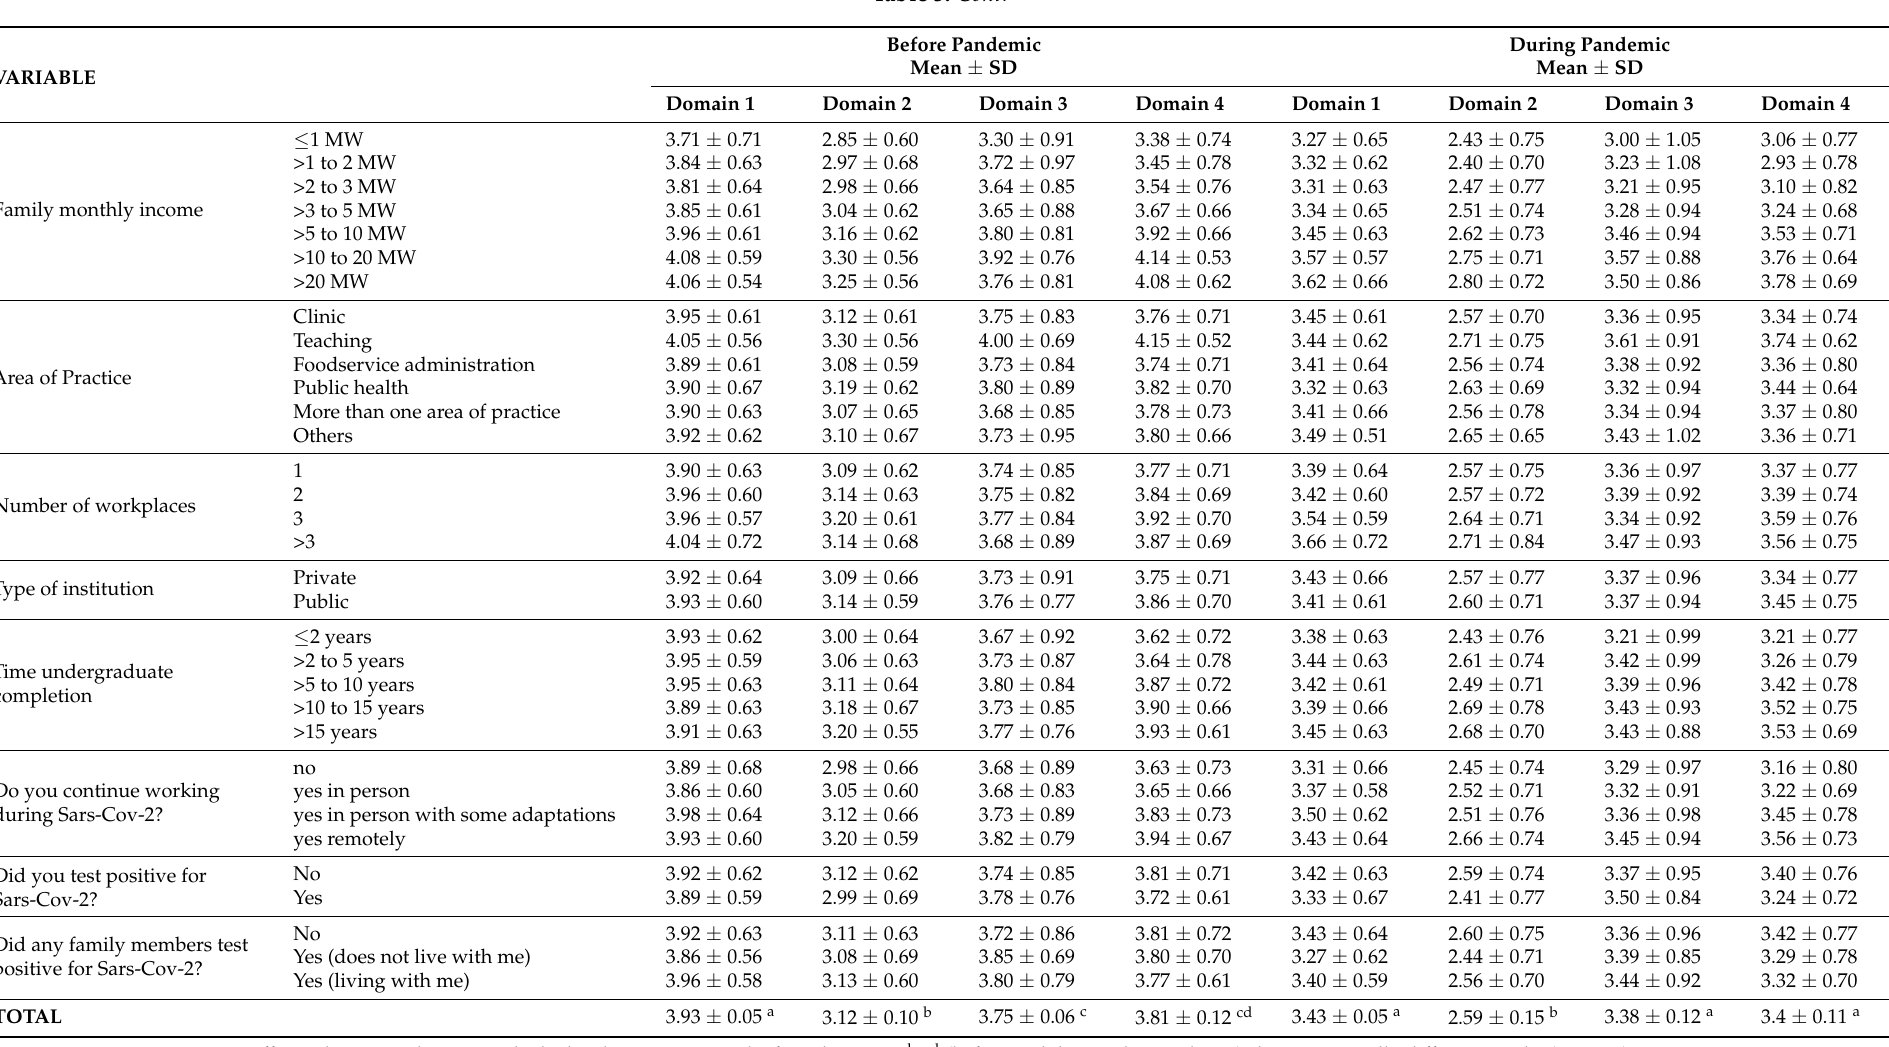
Different lowercase letters inside the last line comparing the four domains a,b,c,d (before and during the pandemic) show statistically different results ( p <